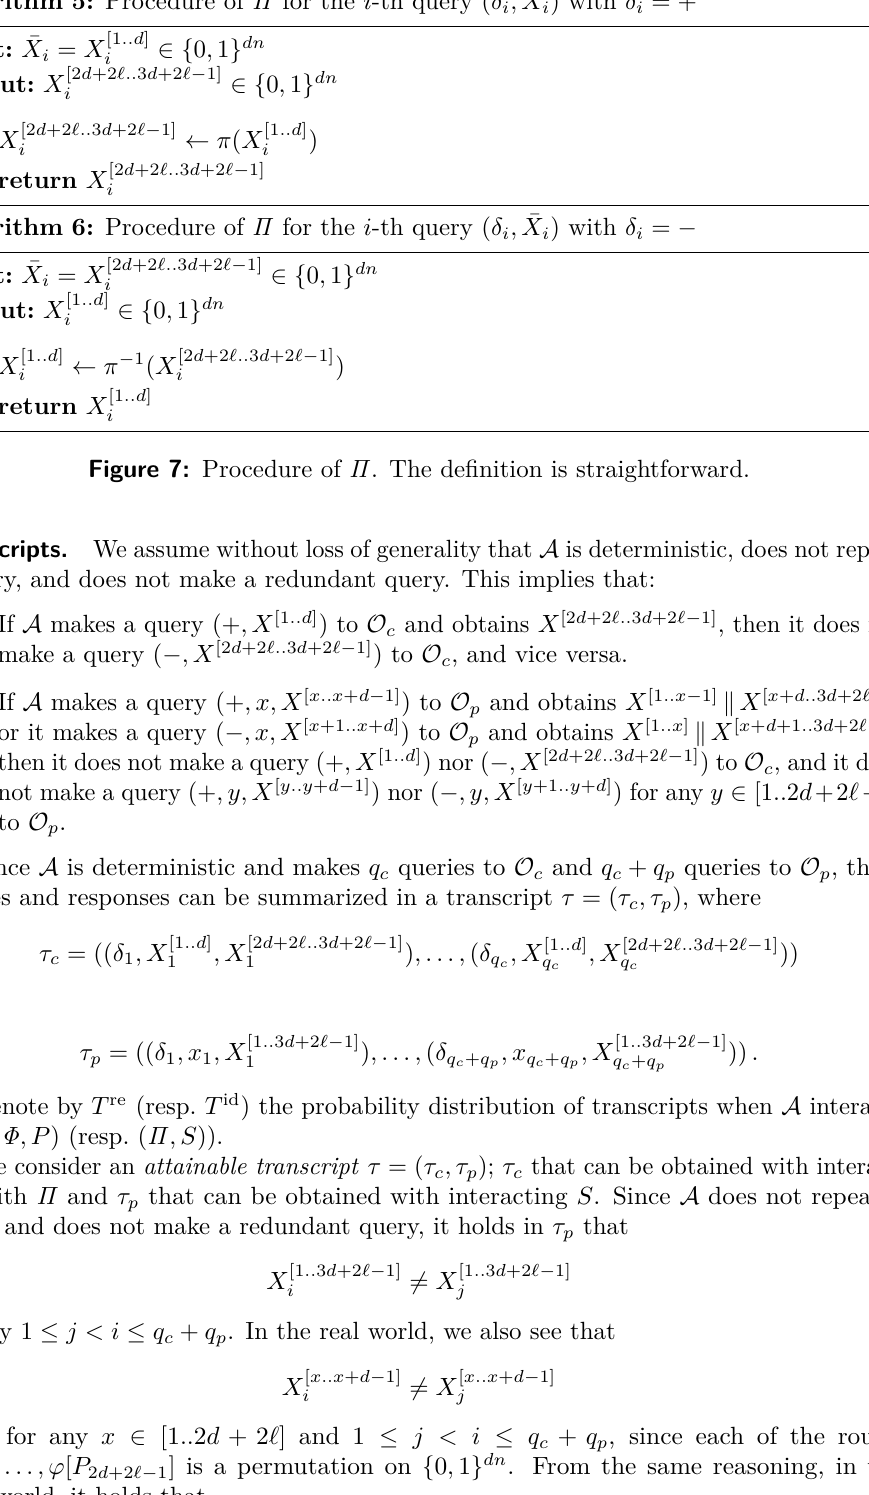
Algorithm 5: Procedure of Π for the i -th query ( δ